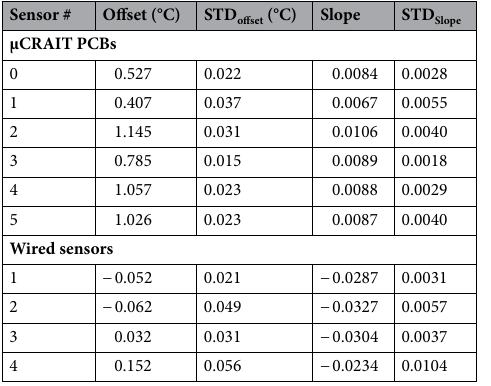
Table 1. Temperature characterization of the µCRAIT box and the wired thermistor sensors.